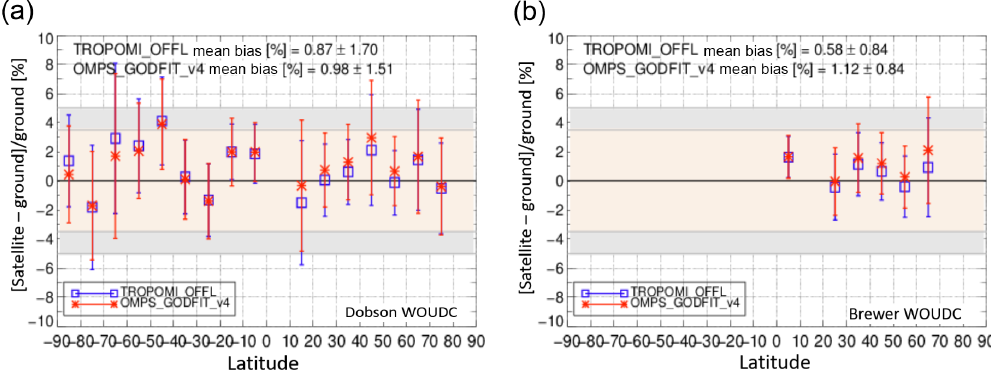
Figure 13. The latitudinal dependency of the percentage differences between the two satellite sensors’ TOC (TROPOMI OFFL and OMPS), processed with the GODFIT v4 algorithm, and Dobson (a) and Brewer (b) GB measurements from WOUDC. The symbol colors are the same as in Fig.